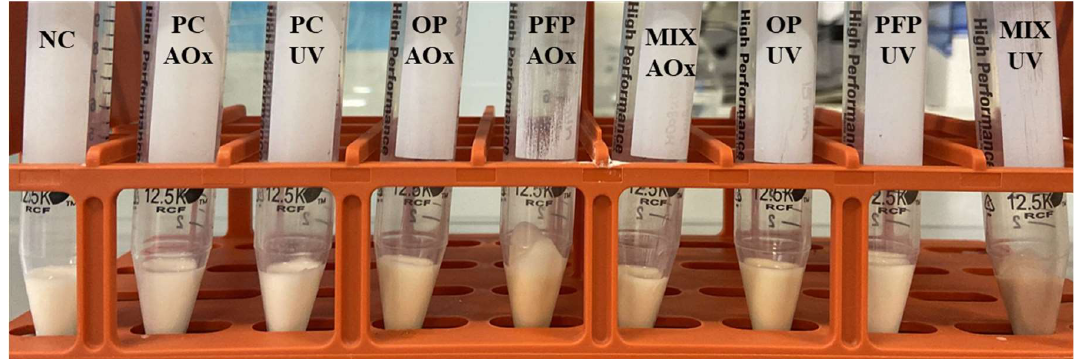
Figure 6. Results obtained for the centrifuge test. NC: negative control; PC-AOx: positive antioxidant control; OP-AOx: onion peel extract antioxidant sample; PFP-AOx: passion fruit peel extract antioxidant sample; Mix-AOx: mixture of antioxidant control and OP and PFP extract; PC-UV: positive UV filter control; OP-UV: onion peel extract UV filter sample; PFP-UV: passion fruit peel extract UV filter sample; Mix-UV: mixture of UV filter control and OP and PFP extract.